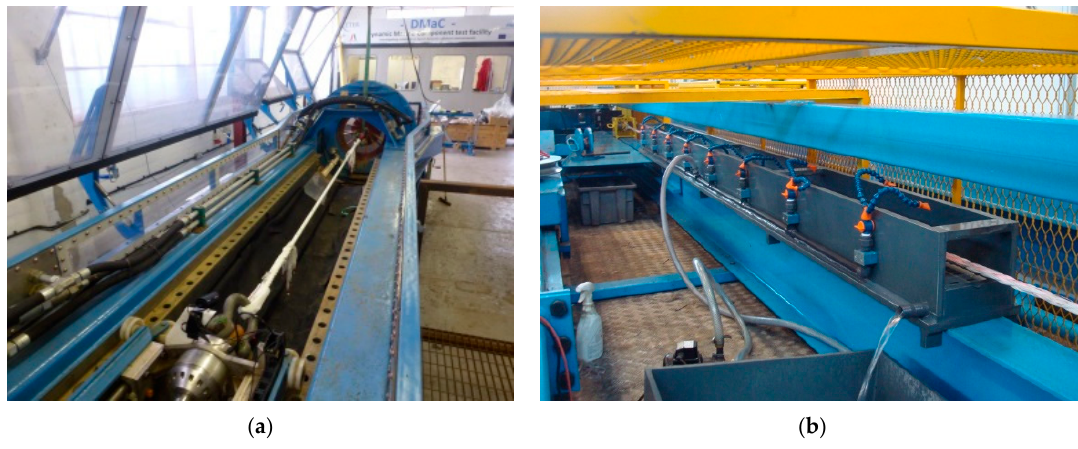
Figure 4. Test set-up at ( a ) Dynamic Marine Component (DMaC) and ( b ) L’Institut Français de Recherche pour l’Exploitation de la Mer (IFREMER). Table 3. Instrumentation at DMaC and IFREMER for Round Robin Testing (RRT) campaign.